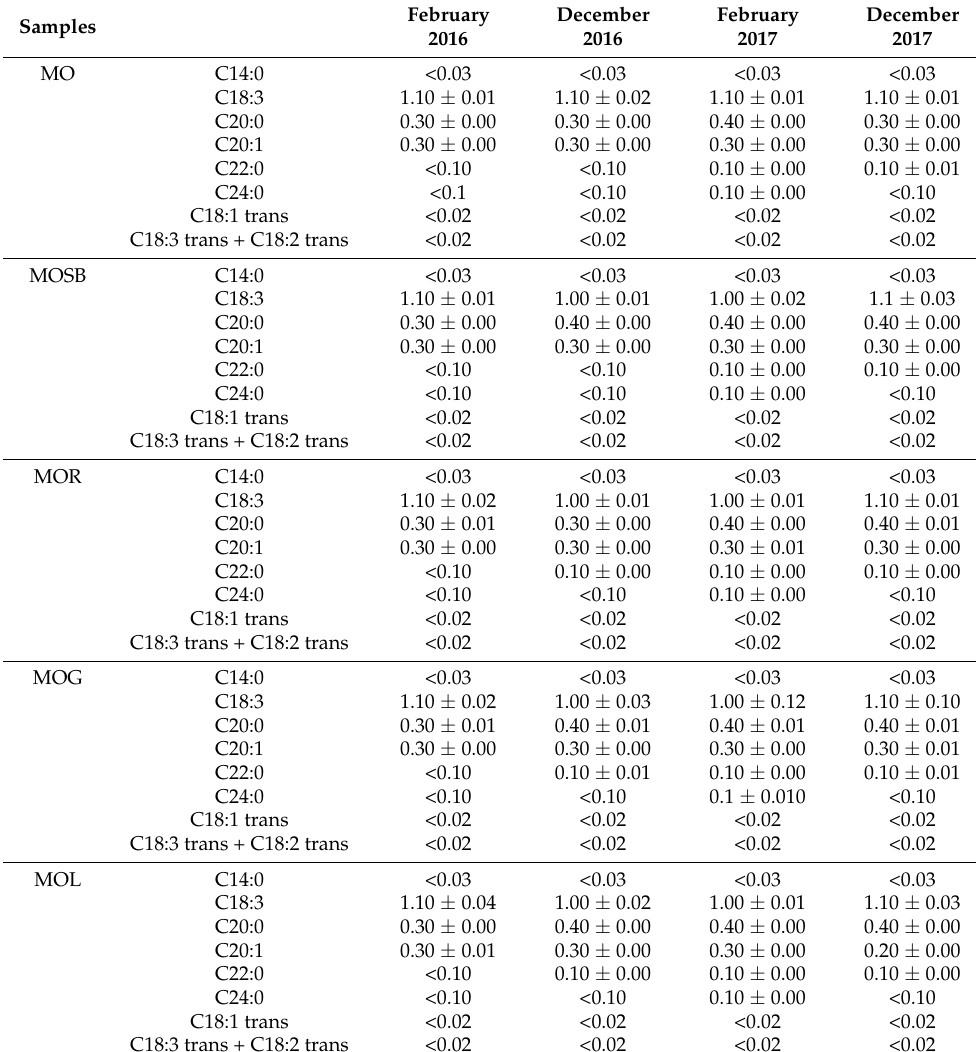
Table 6. The percentage of fatty acids (%) of all olive oils. Samples